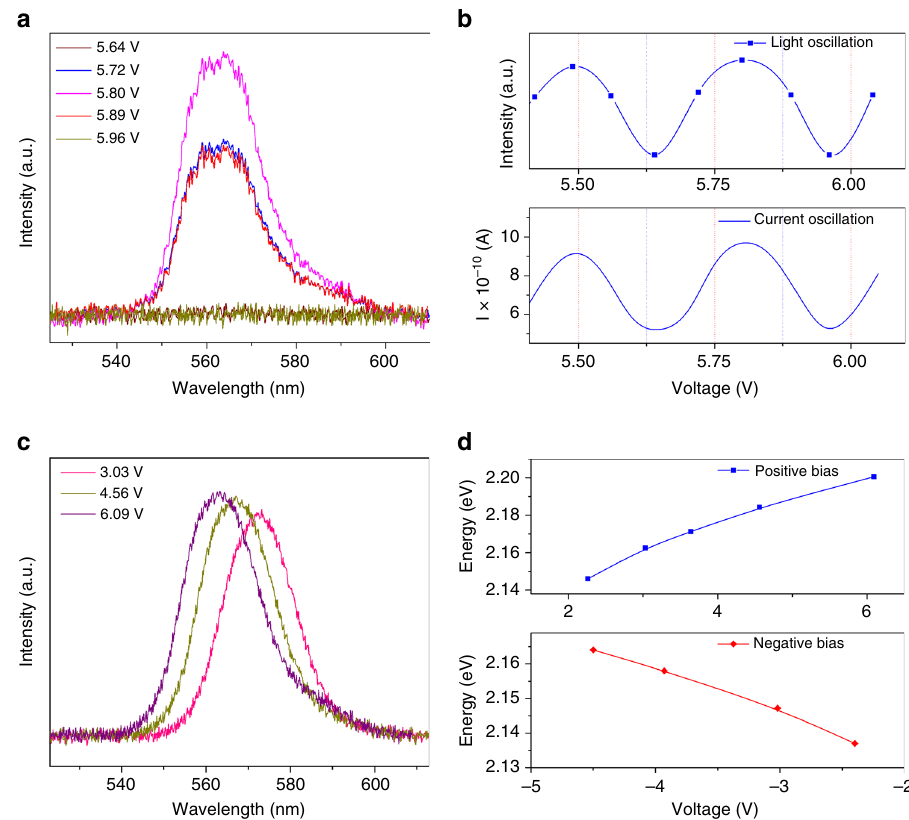
Fig. 2 Oscillatory electroluminescence intensity. a EL spectra collected at the peak and valley of a particular resonance energy. The emission intensity oscillates with the same period of tunnel current. b Plots of emission intensity and magnitude of tunnel current with different bias voltage demonstrate oscillations of carrier injection. c EL spectra taken at the maxima of different resonance current. d Variation of emitted photon energy with bias voltage. The emitted photon energy increases with bias voltage due to the resonance tunneling to the higher energy